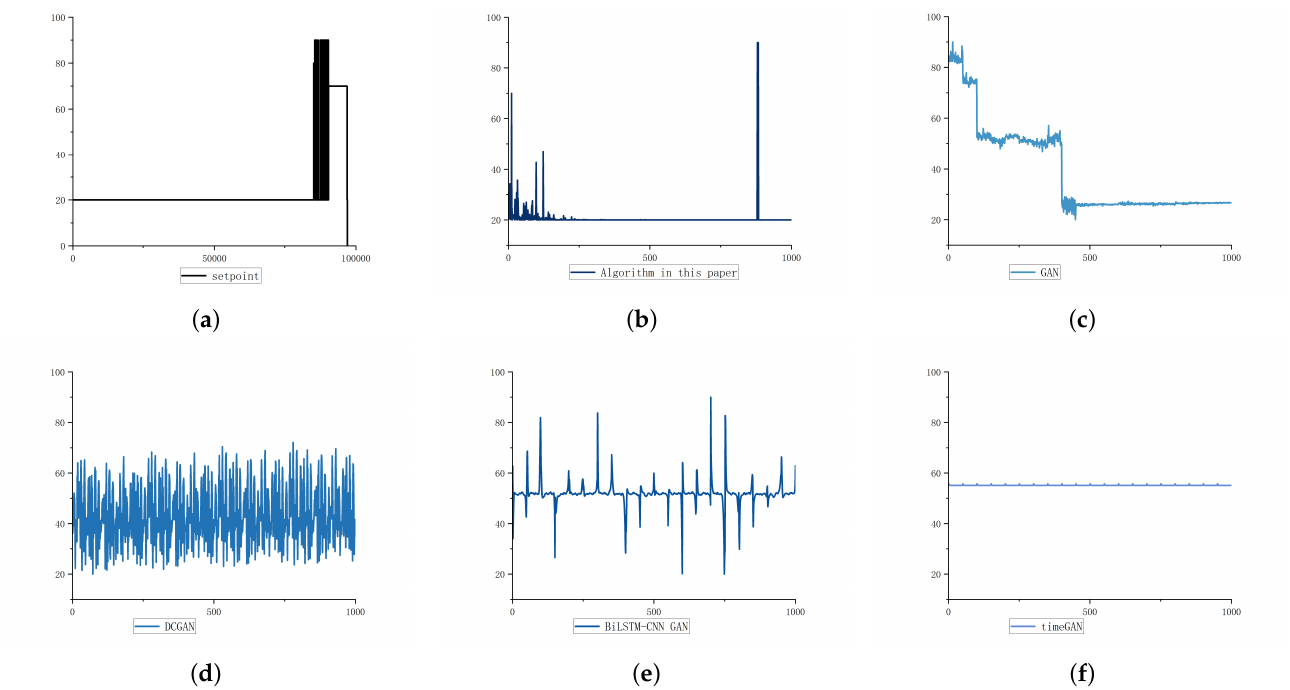
Figure 9. ( a ) Original data of the Setpoint feature of the Mississippi gas dataset; ( b ) generation results of the algorithm in this paper; ( c ) generation results of GAN; ( d ) generation results of DCGAN; ( e ) generation results of BiLSTM-CNNGAN; ( f ) generation results of